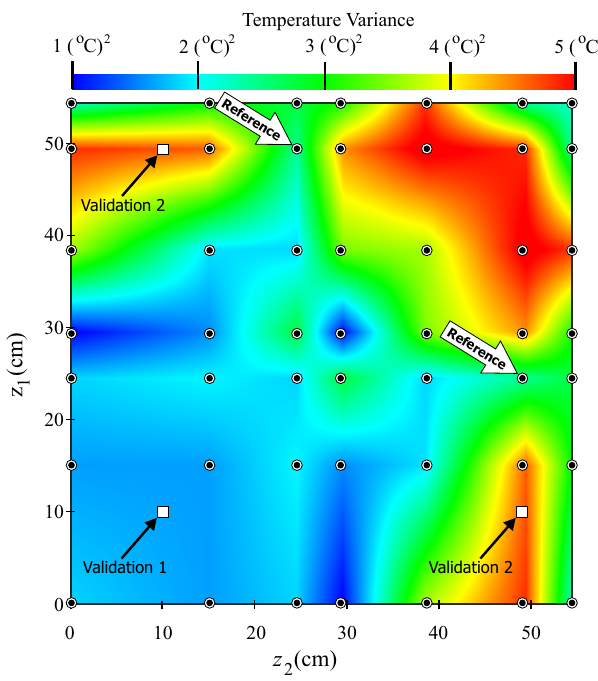
Figure 11. Temperature variance using bilinear